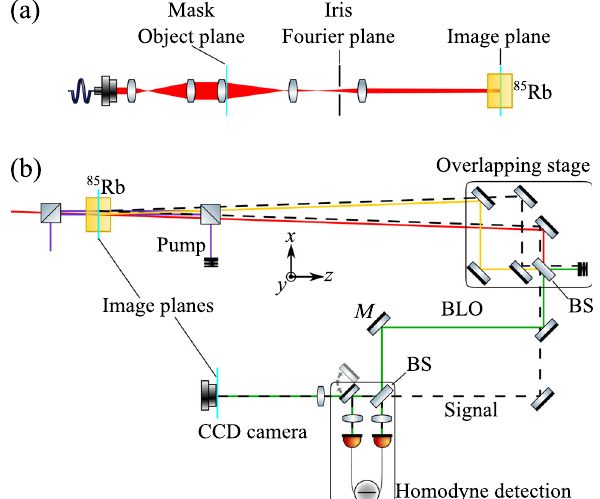
FIG. 5. Schematic diagram of the setup. (a) The path of the seed to the vapor cell, with mask and filtering iris positions. (b) The creation and measurement of the squeezed vacuum. The dashed black lines depict the vacuum fields, which at all points contain both the probe and conjugate frequencies. The solid lines depict bright fields. The red and yellow lines represent probe and conjugate LO frequencies, respectively. The green line represents the BLO, the purple the pump field. The cyan lines show the mask object and image positions. Where the vacuum and LO fields are slightly offset in the diagram, they are actually separated vertically in the experiment. Nonetheless, we use a single beam splitter (BS) for both of them in the over- lapping